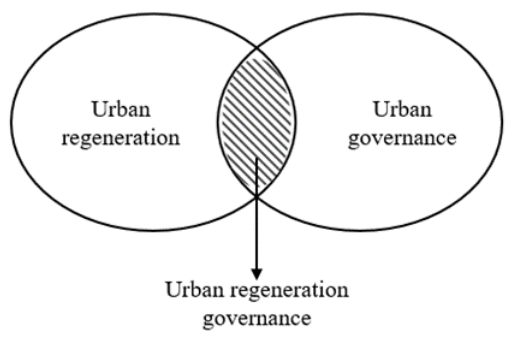
Figure 1. The definition of urban regeneration governance.